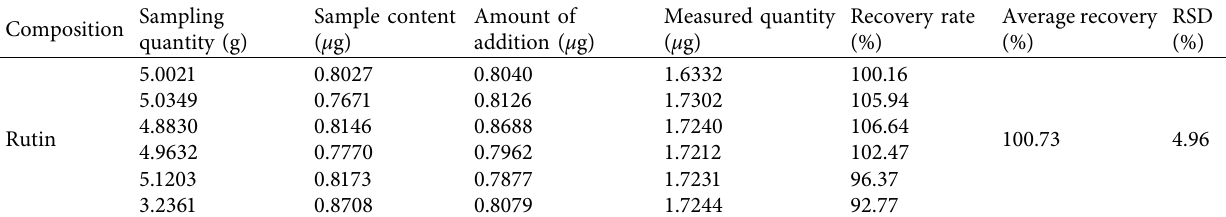
Table 4: Rutin’s sample recovery experiment.